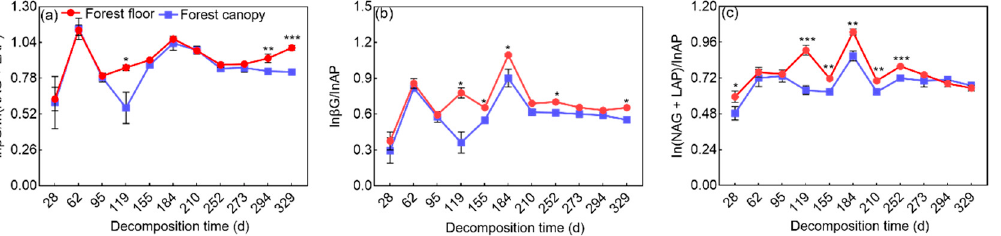
Figure 3. Dynamics of enzyme stoichiometry during the decomposition of leaf litter in the forest canopy and floor. These were the enzyme C:N, C:P and N:P ratios obtained by calculating ln β G/ln LAP + NAG ( a ), ln β G/ln AP ( b ) and ln(LAP + NAG)/ln AP ( c ) activity ratios, respectively. Notes: * indicate significant differences in enzyme stoichiometry at each sampling time in different habitats. ( p < 0.05 *, p < 0.01 **, p < 0.001 ***).